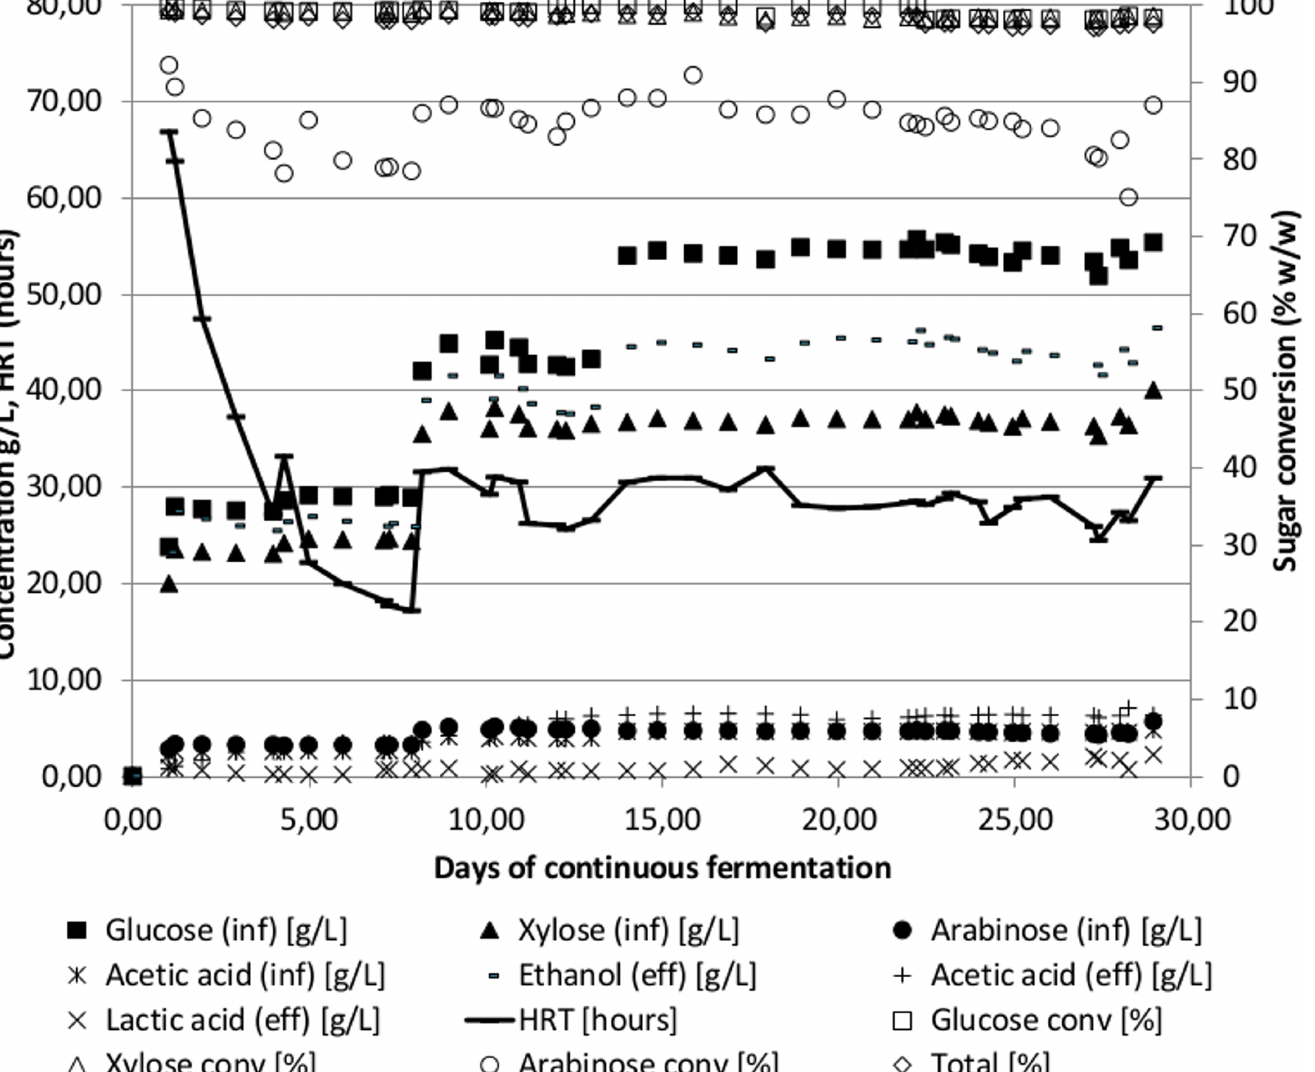
Fig 3. Time course of continuous fermentation of un-detoxified corn cob hydrolysate using the thermophilic anaerobic bacterium Thermoanaerobacter Pentocrobe 411X. Inf: HPLC data from the influent bottle. Eff: HPLC data from the reactor effluent. Ethanol (eff) is a combination of ethanol in the reactor effluent and ethanol from the gas phase exiting the reactor system. The conversion of sugars in % is based on the concentration in the reactor relative to the concentration in the influent. HRT: Hydraulic retention time.